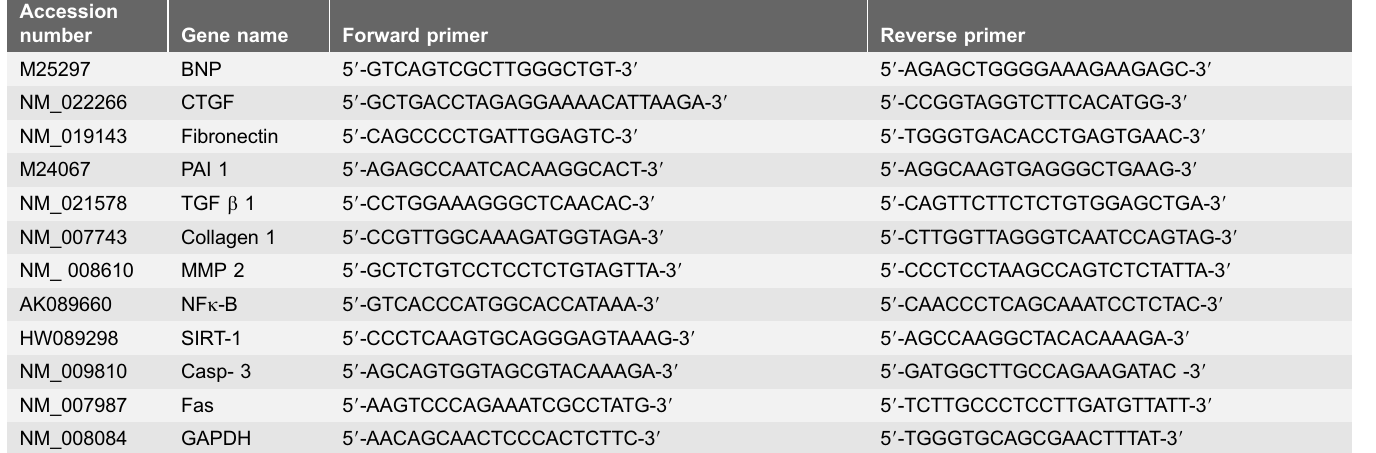
Table 1. The oligonucleotide primers sequence of studied genes and the housekeeping